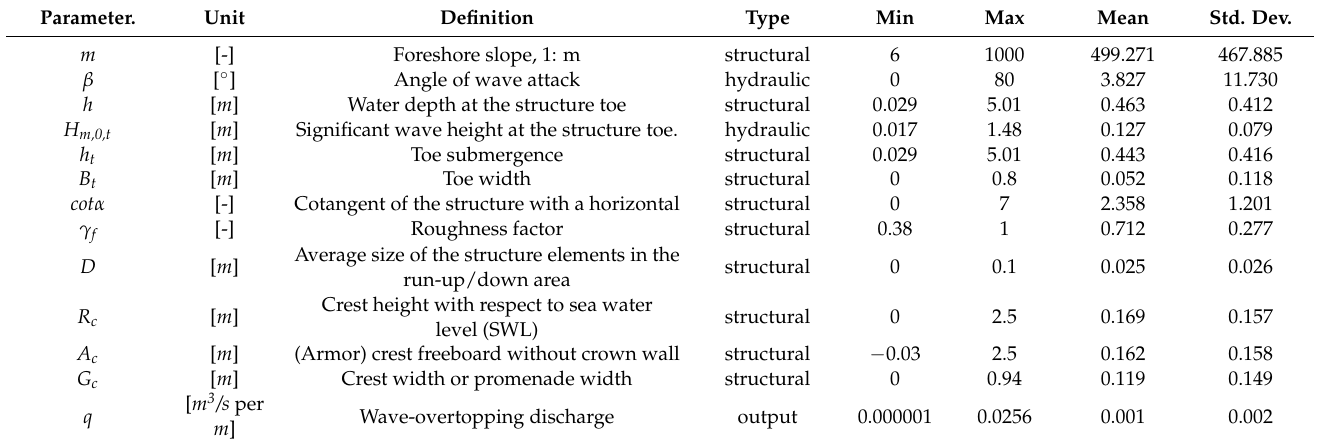
Table 2. Statistics of parameters for coastal structures with straight